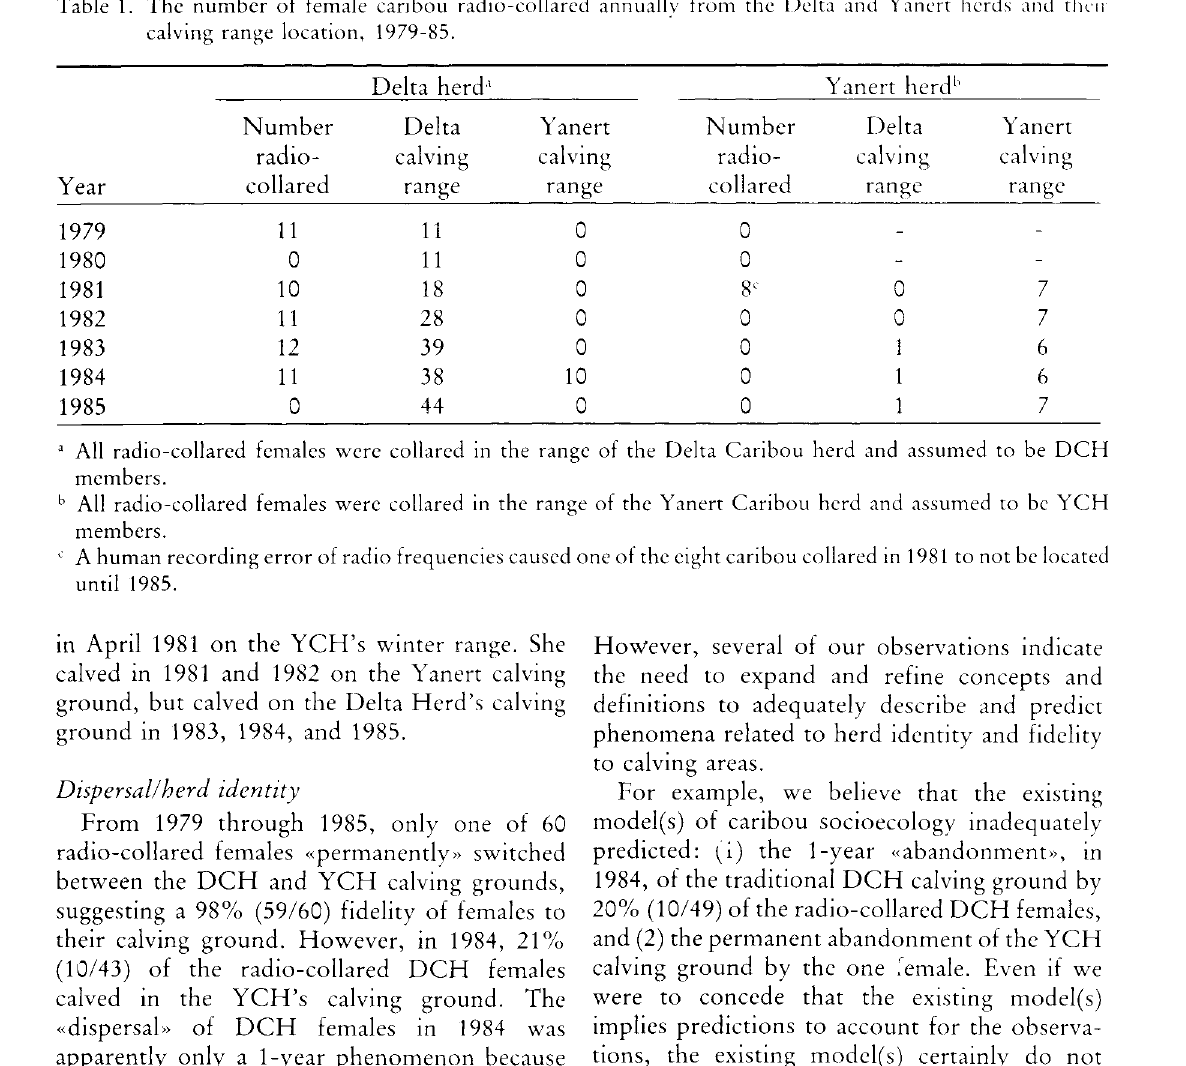
Table 1. The number of female caribou radio--collared annuallv from the Del Ita and Yanert h erds and then calving range location,